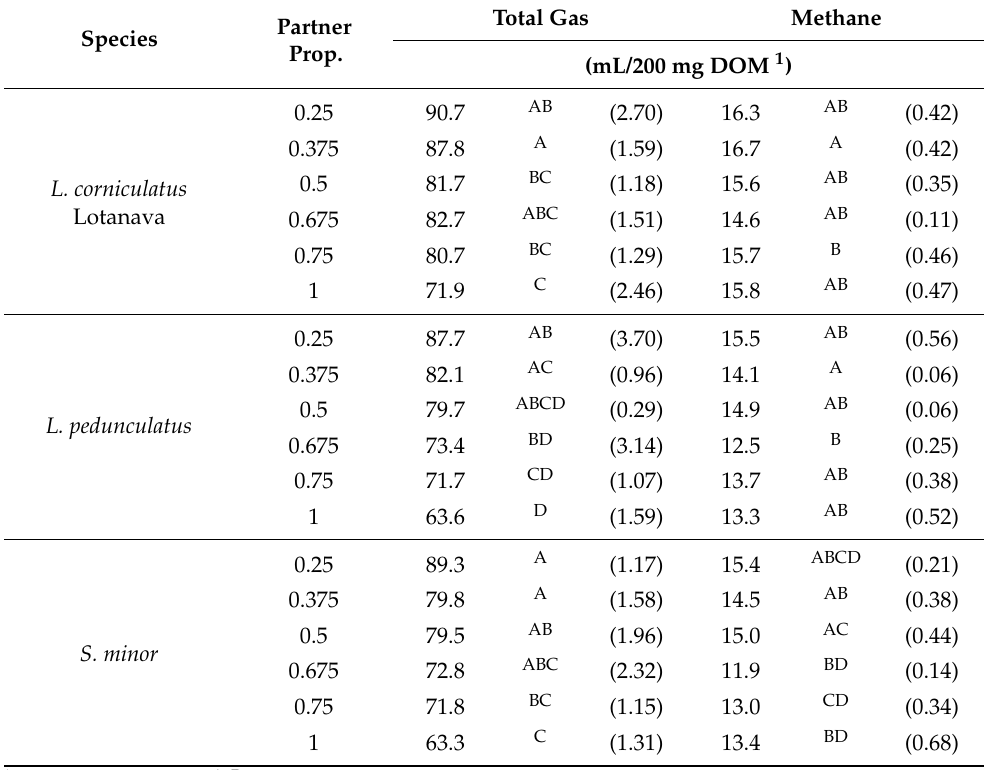
Table 5. Mean values of measured in vitro fermentation parameters in a 24 h incubation period